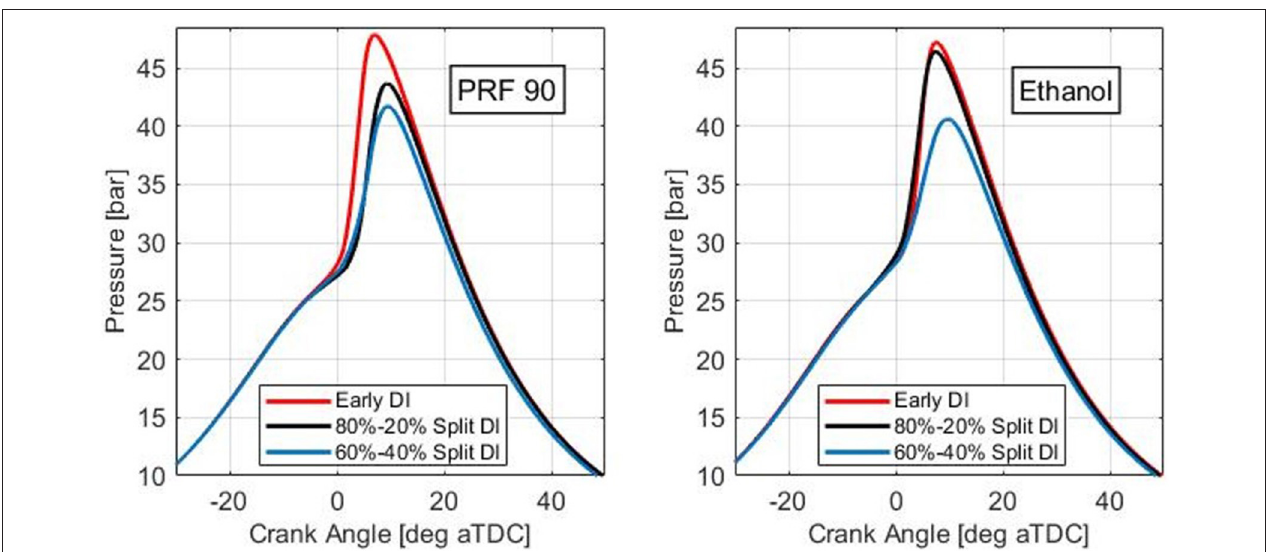
Frontiers in Mechanical Engineering |